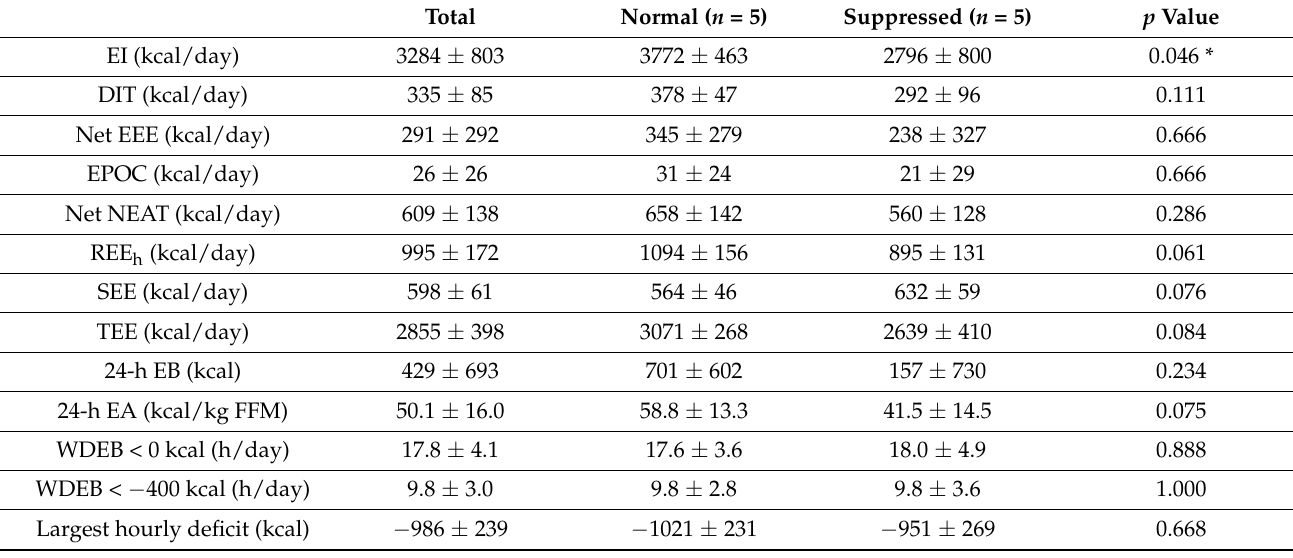
Table 4. EI, EE components, and WDED variables of the participants during rest